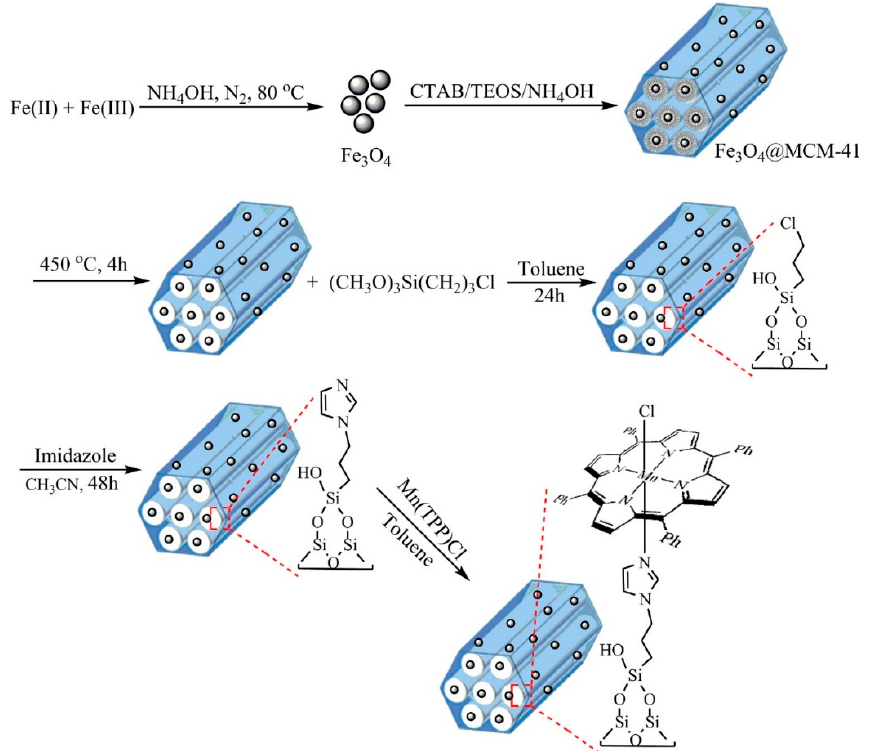
Figure 61. Schematic diagram for preparation of Fe 3 O 4 @MCM-41-Im@MnPor. Reproduced with permission from [162]. Copyright 2018 Elsevier B.V.